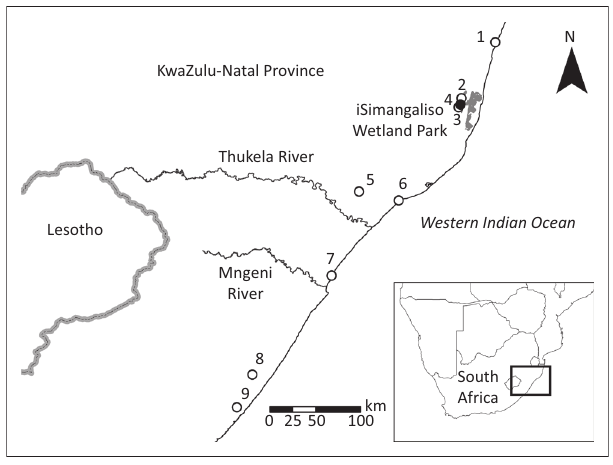
Source : Drafted by Willem Coetzer; South African Institute for Aquatic Biodiversity FIGURE 1: Sampling localities of Potamonautes sidneyi (open circles) and Potamonautes isimangaliso (filled circle) in KwaZulu-Natal, South Africa: (Site 1) Lake Sibaya, (Site 2) Mpophomeni Stream, (Site 3) Hluhluwe, (Site 4) Dukandlovu Pan, (Site 5) Entumeni, (Site 6) Siyayi, (Site 7) Mhlanga, (Site 8) Oribi Gorge and (Site 9)